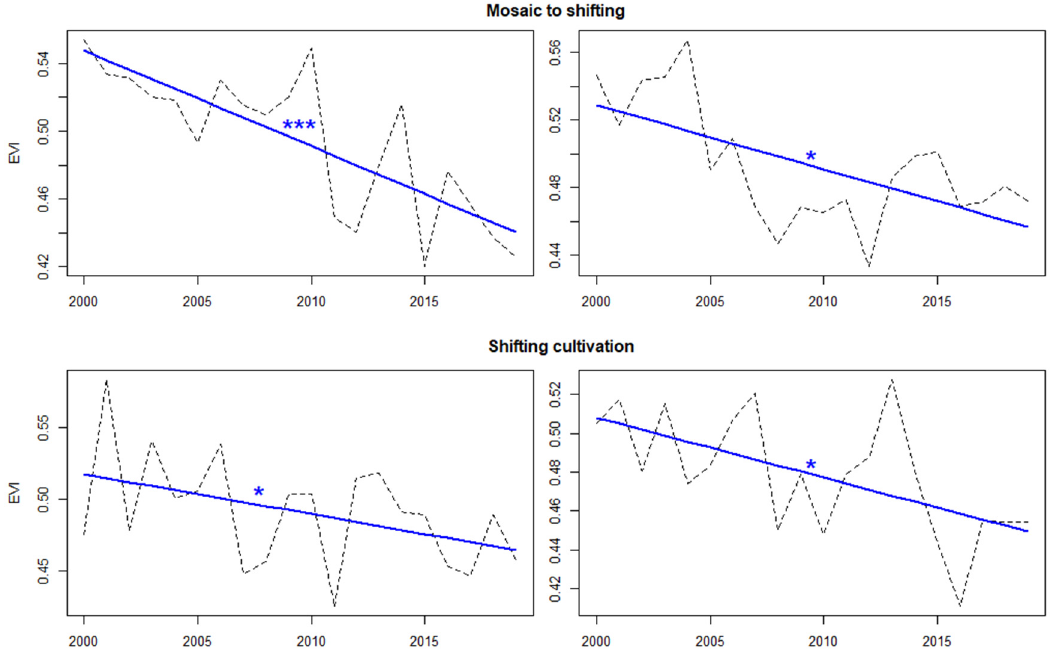
Figure 11. Trend (blue line) of annual peaking magnitude for mosaic to shifting ( top ) and shifting cultivation ( bottom ). The symbol * shows the trend is significant, * has p value less than 0.05 and *** has p value less than 0.000001. EVI range for y -axis is not constant for each plot.